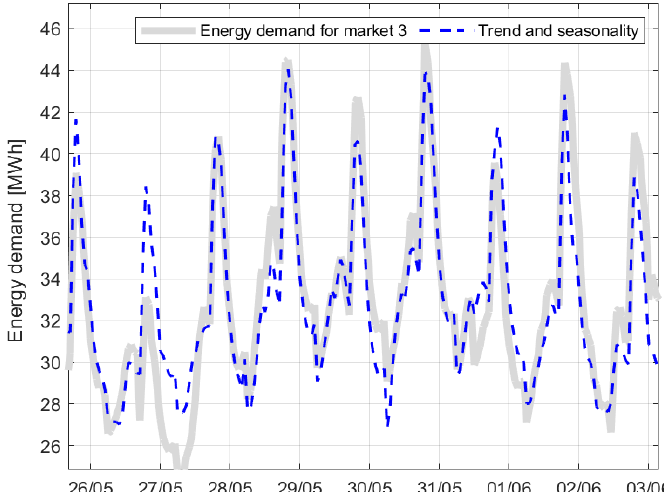
Energies 2020 , 13 , x FOR PEER REVIEW Figure 5. Daily energy demand for Market 3 between 26 May 2018–2 June 2018. Figure 5. Daily energy demand for Market 3 between 26 May 2018 – 2 June 2018. Figure 5. Daily energy demand for Market 3 between 26 May 2018 – 2 June 2018.